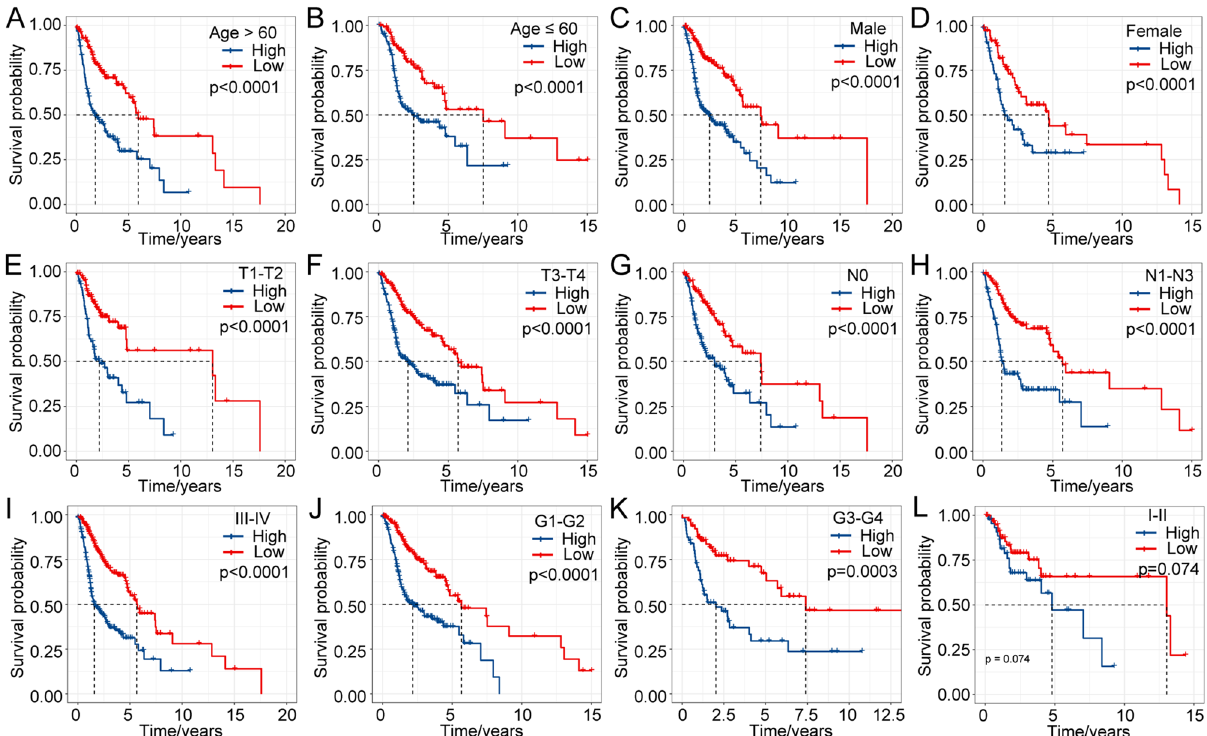
Figure 7. Prognostic efficiency of the risk model in patients with different clinical characteristics in the TCGA